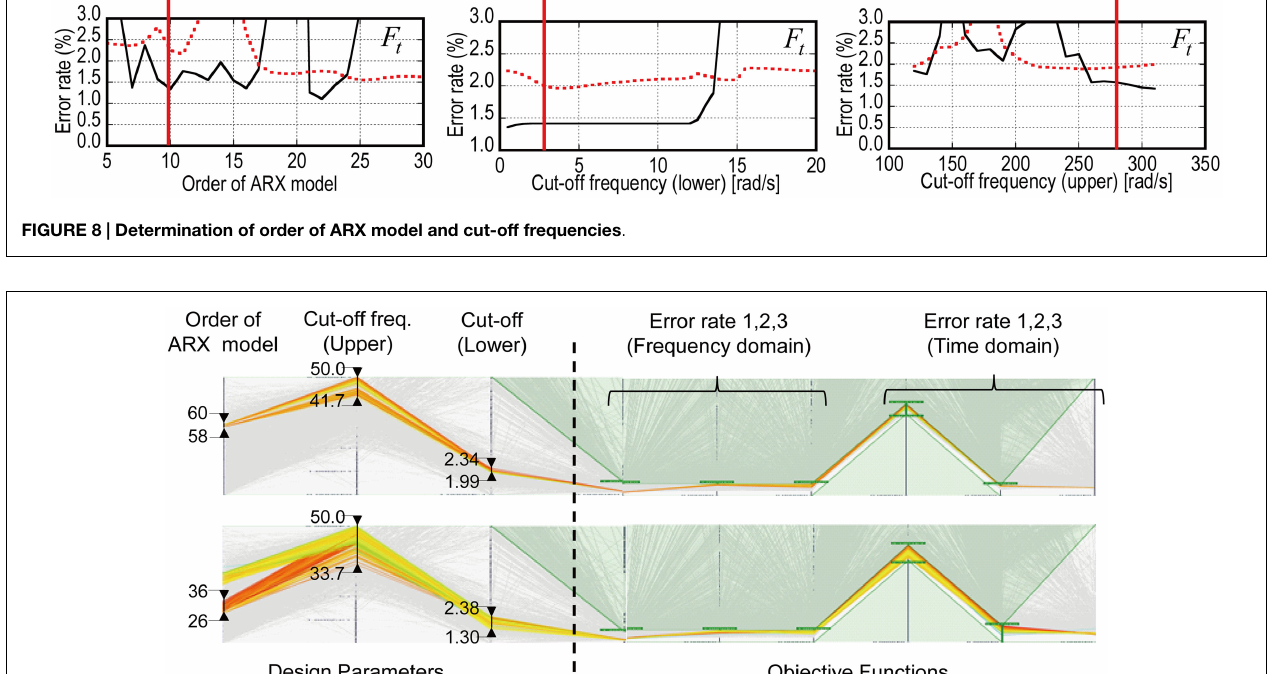
FIGURE 9 | Multi-dimensional analysis for optimal combination of identification parameters .